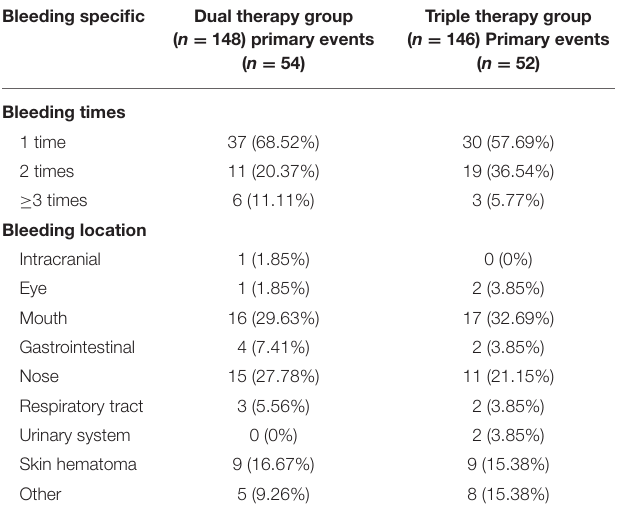
TABLE 3 | Bleeding Times and Specific Location of Bleeding in 2 Groups of Patients; “Others” were cases in which the bleeding site could not be identified, but were identified as bleeding by the research team due to Hb decrease.